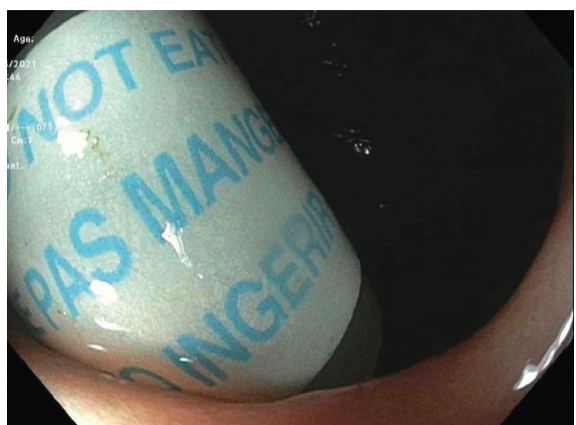
Figure 1: Cylindrical foreign body labeled “DO NOT EAT” in the cecum.